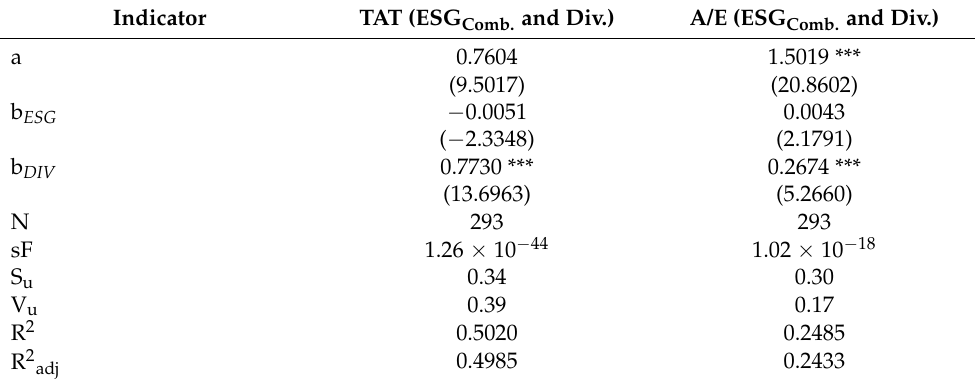
Table 12. Regression results (with an additional variable describing the level of diversification of the entity’s activity). TAT (ESG Comb. and